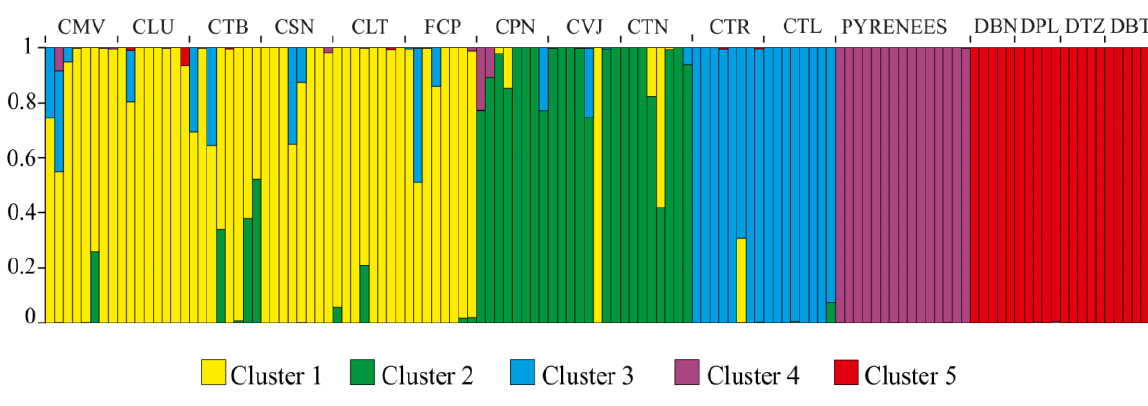
Figure 3. Probability of assignment to each of the five clusters obtained with the Bayesian approach (Structure, version 2.3.4 [13]) for each of the 123 individuals of G. lutea analyzed. Individuals are sorted according to their population of origin (codes on